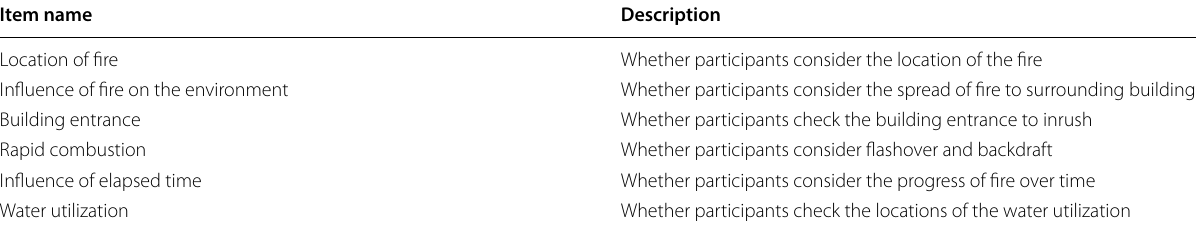
Table 2 Evaluation items for reconnaissance activity